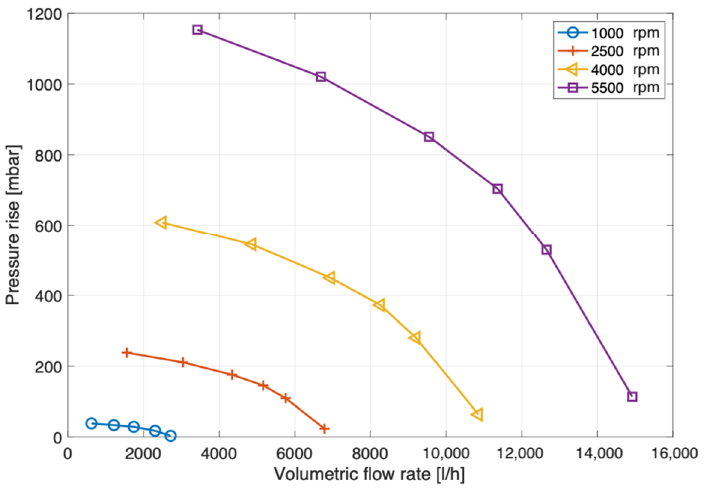
Figure 9. Cooling system pump map.